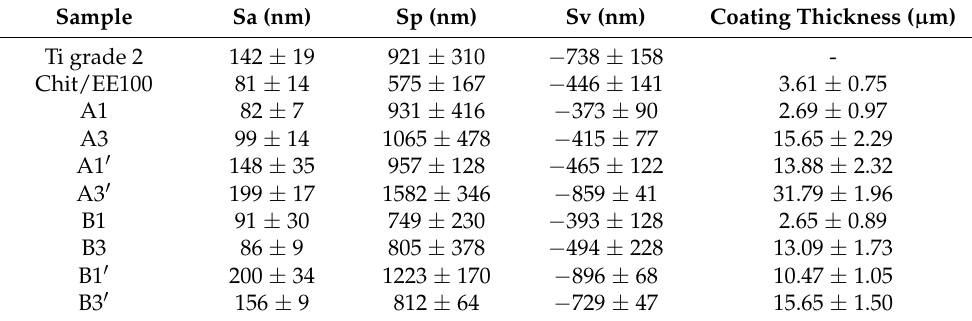
Table 3. Surface topography parameters and coatings thickness of the studied samples.